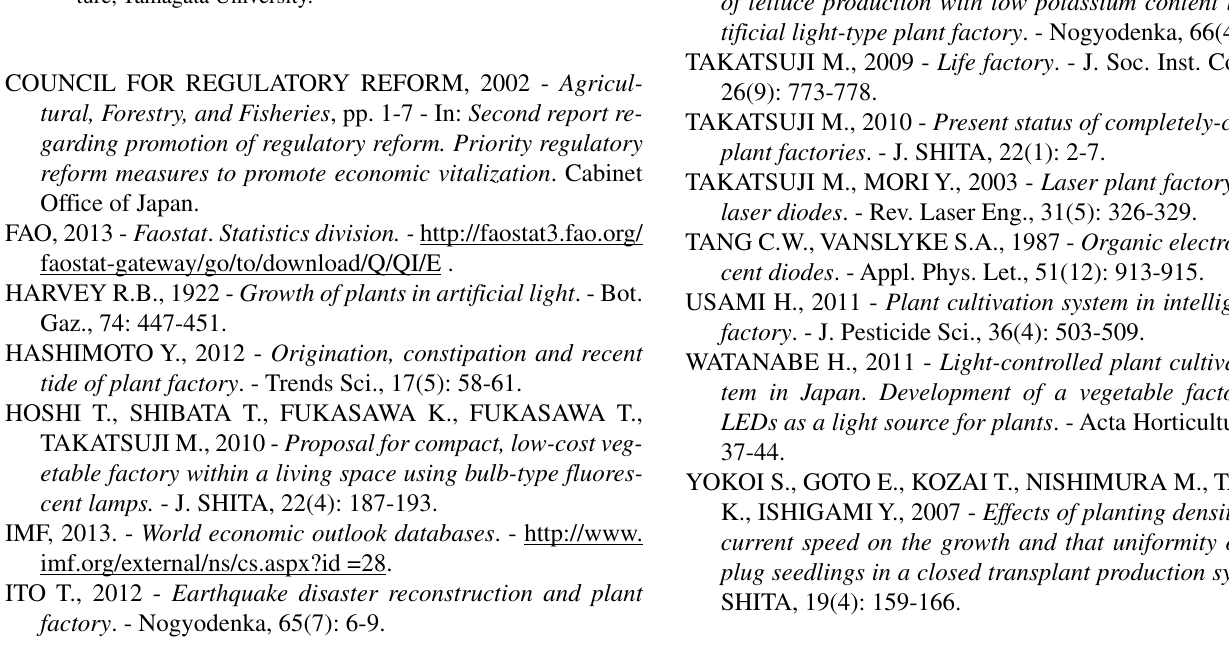
Fig. 7 - Strawberry (A) and leafy lettuce (B) grown under white-light organic electroluminescence display at the Faculty of Agricul- ture, Yamagata